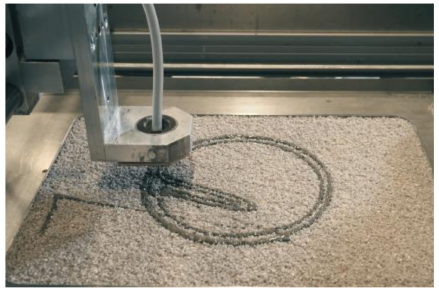
Figure 3. SPI printer used for the investigations